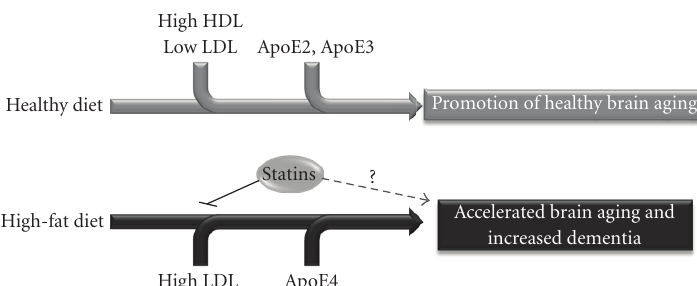
Figure 2: Factors that influence in the progression of normal and pathological brain aging. The scheme shows how the interaction between di ff erent dietary and genetic factors (ApoE alleles) leads to di ff erent final outcomes in regards to brain